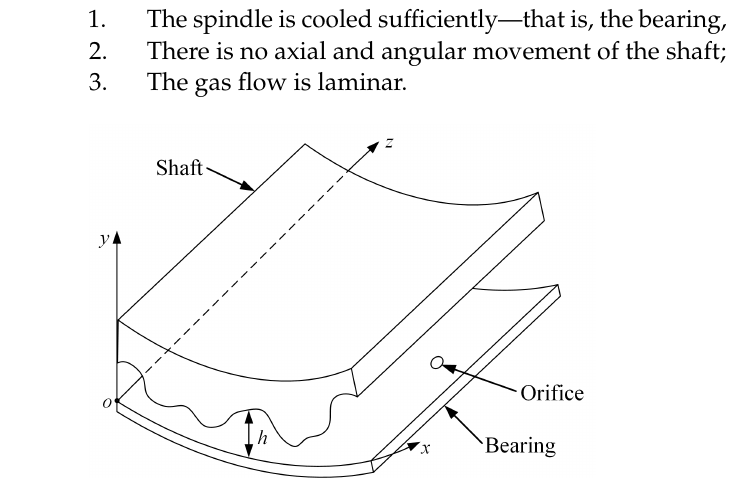
Figure 2. Circumference cylindrical